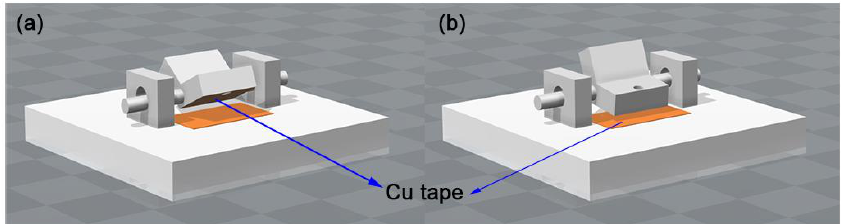
Figure 1. Schematic for the V-shaped actuator. ( a ) Actuator with power off. It floats in the air in equilibrium. ( b ) Actuator in the powered state. Electrostatic attraction occurs and the actuator sticks to the floor. At this time, the opposite panel is raised. All schematics were drawn by the author using SolidWorks software (Dassault Systems SolidWorks Corp., Waltham, MA,